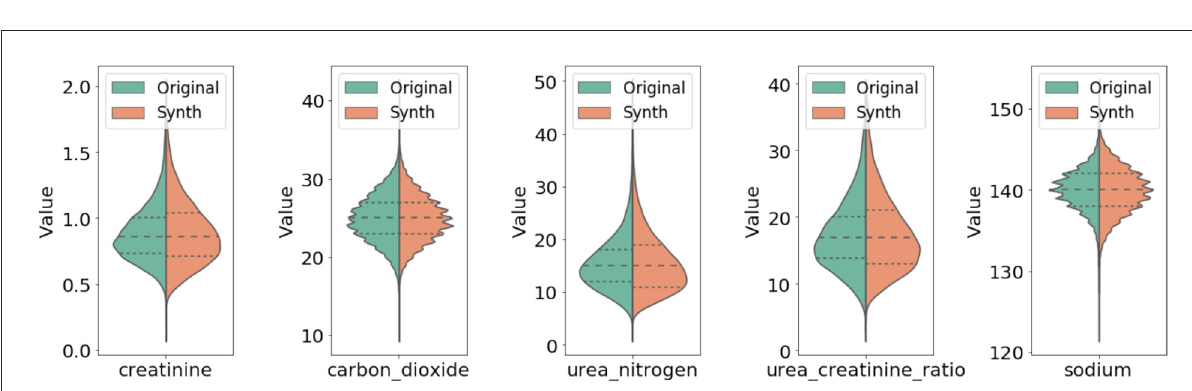
FIGURE3 Comparison of marginal distribution of lab values between original and synthetic data. The three horizontal dotted lines in each violin plot from top to the bottom represent the third quartile, median, and the first quartile, respectively.